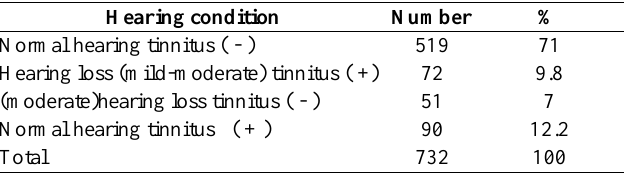
Table 1: distribution of patients by hearing levels in Al-Rusafa Baghdad city